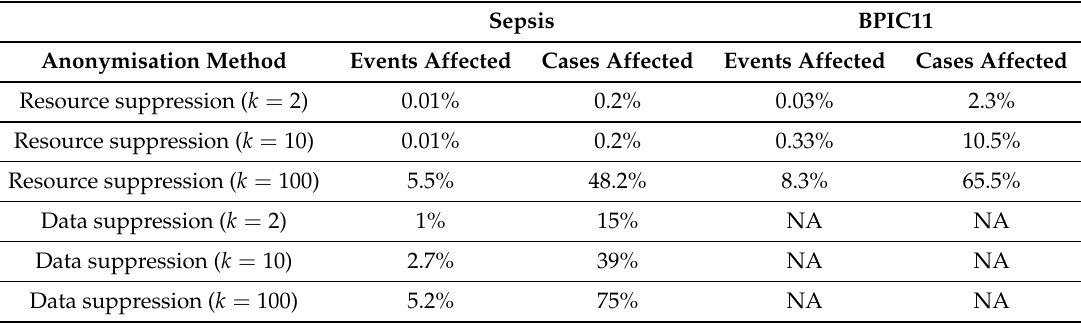
Table 4. The percentage of cases and events affected by the application of resource and data anonymisation to the Sepsis log and the BPIC11